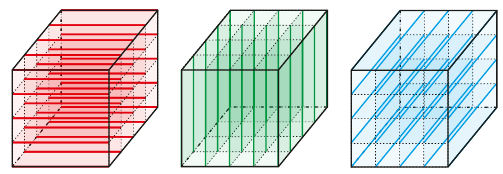
Figure 2. Three dexel planes in the Tri-Dexel method to represent spatial bodies.